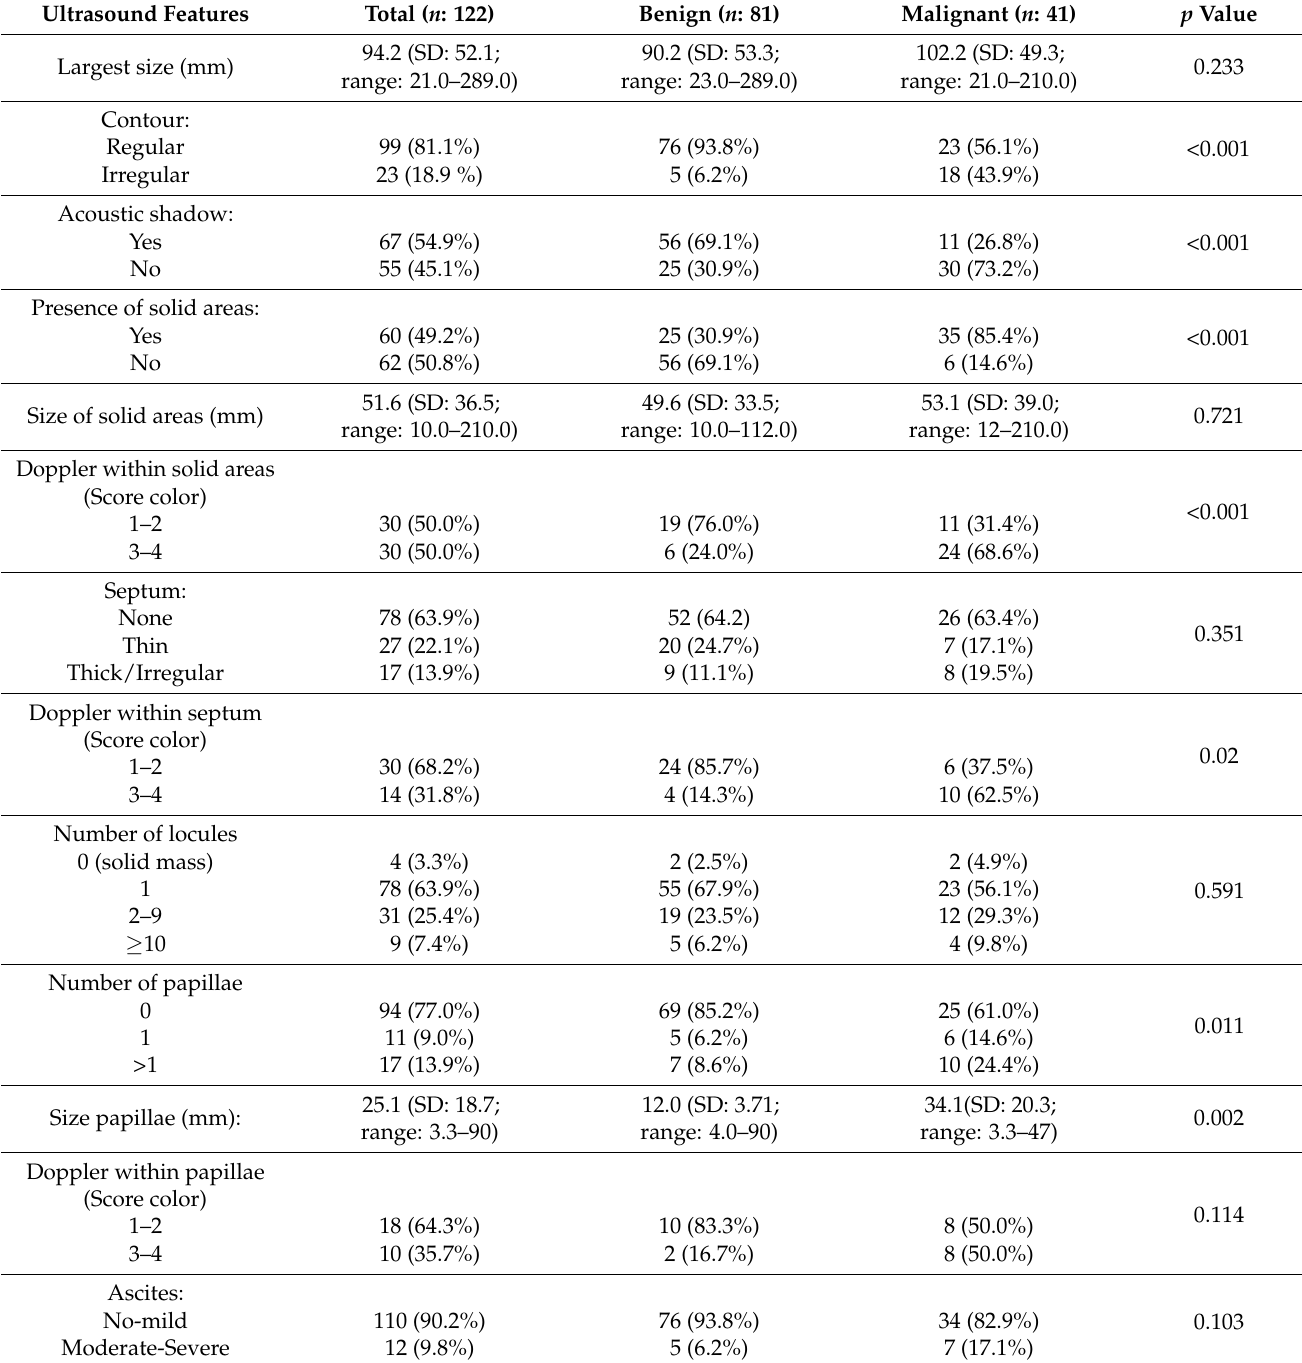
Table 7. Ultrasound findings in this series.